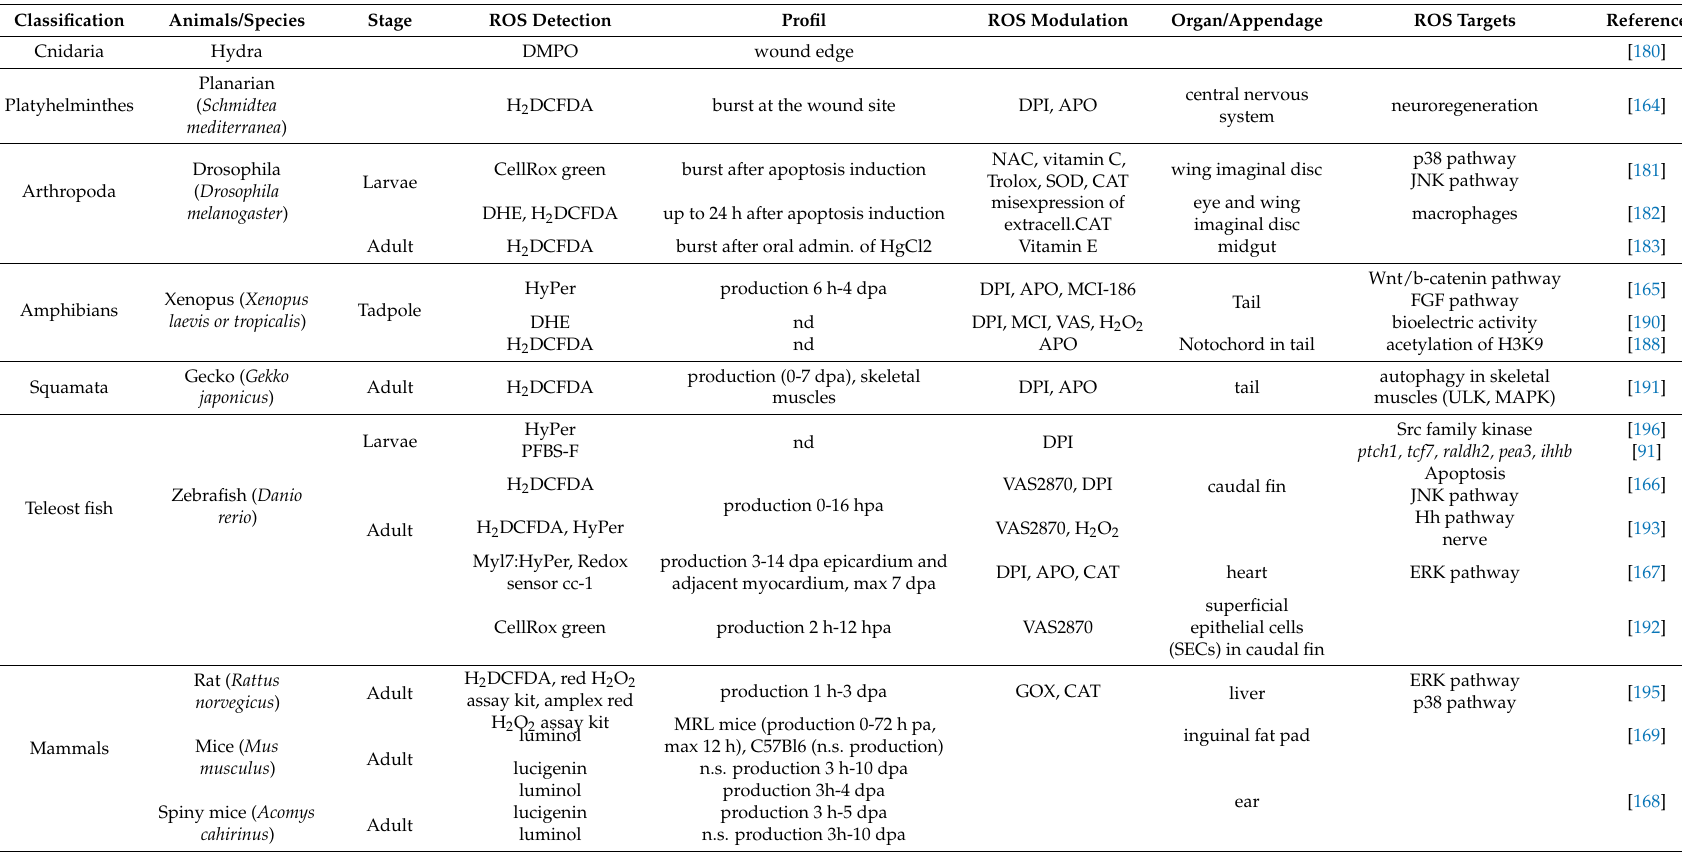
Table 2. Redox regulation of regeneration among Phyla. APO. apocynin; DHE: dihydroethidium; dpa: days post-amputation; hpa: hours post amputation; n.s.: no